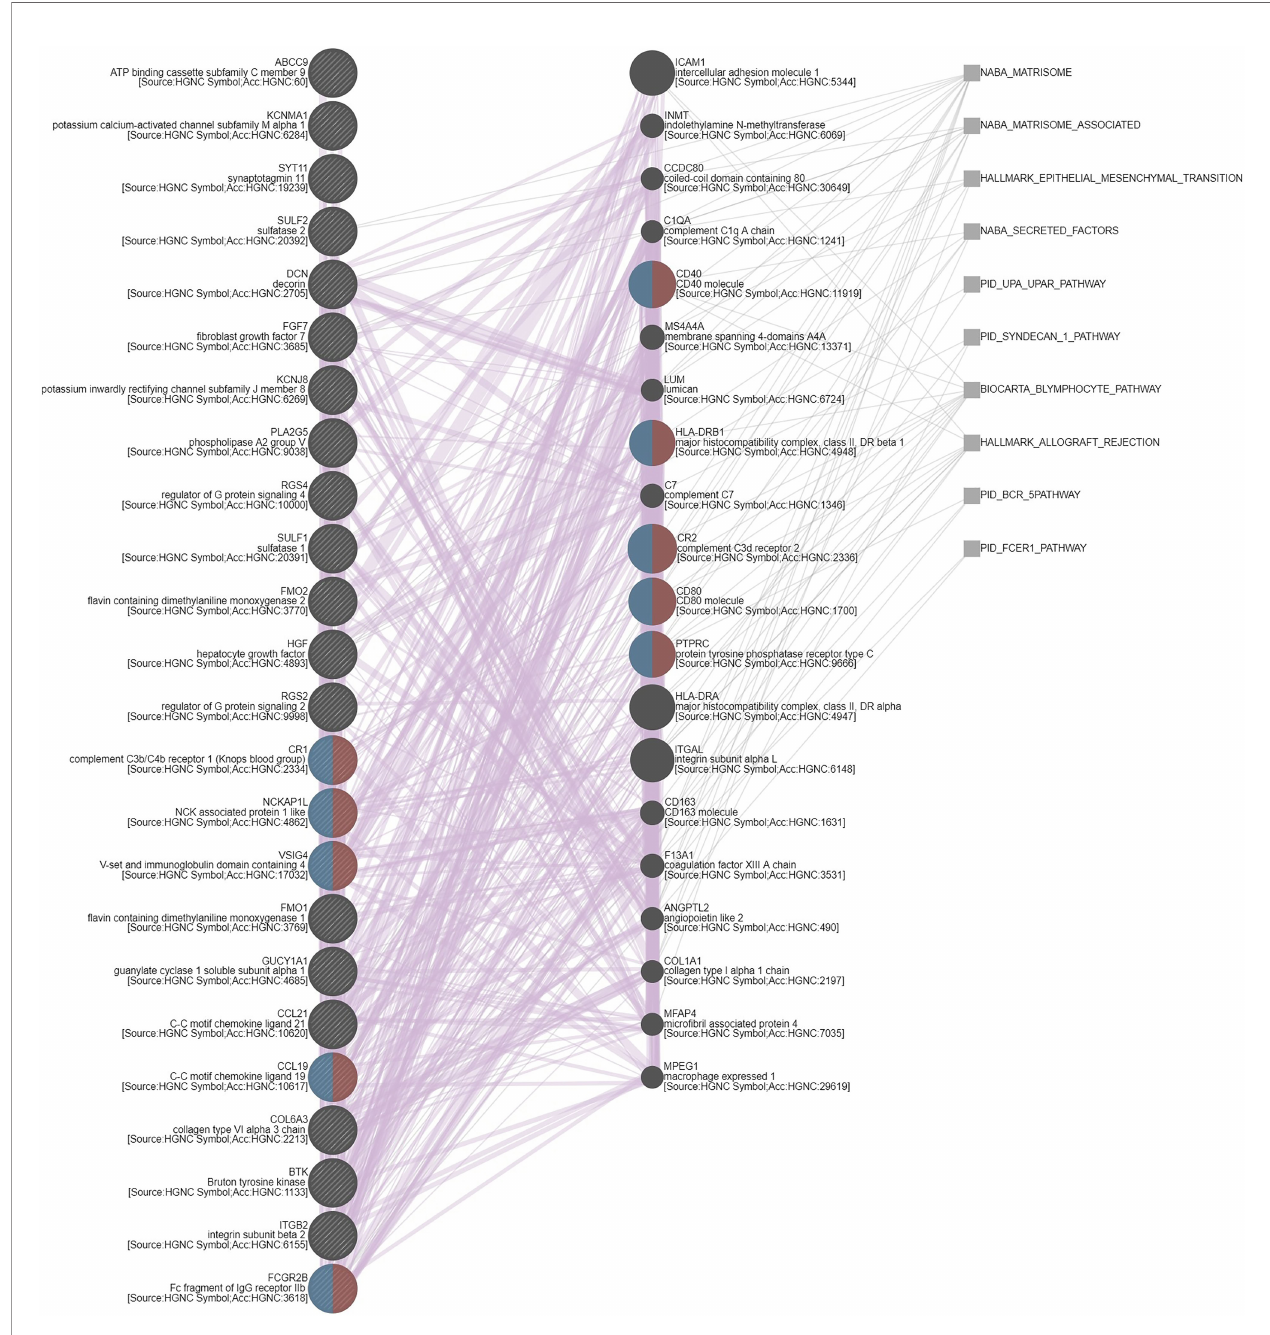
FIGURE 6 | Gene coexpression network. A weighted network that connects key genes to each other was built using the GeneMANIA prediction server. Red and blue semicircles represent genes that belong to mononuclear cell proliferation and lymphocyte proliferation, respectively. Purple and grey lines indicate coregulation and pathways,